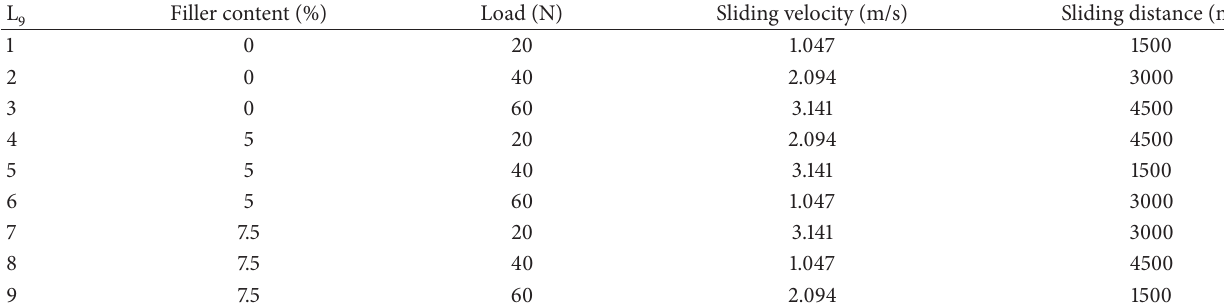
Table 4: L 9 ( 3 4 ) orthogonal arrays.